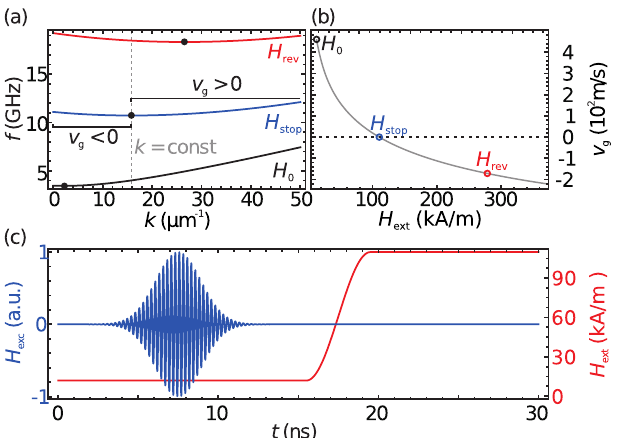
Figure 1. ( a ) Dispersion relations of Backward-Volume waves for three magnetic field strengths. The black dots mark the wave vectors with vanishing group velocity. ( b ) Group velocity at fixed wave number k = 15.8 µ m − 1 for varying magnetic field strength. The colored circles mark the field strengths used in panel ( a ). ( c ) Time profile of the exciting magnetic field (blue) and the external magnetic field H ext (red) with target field H stop = 139 mT